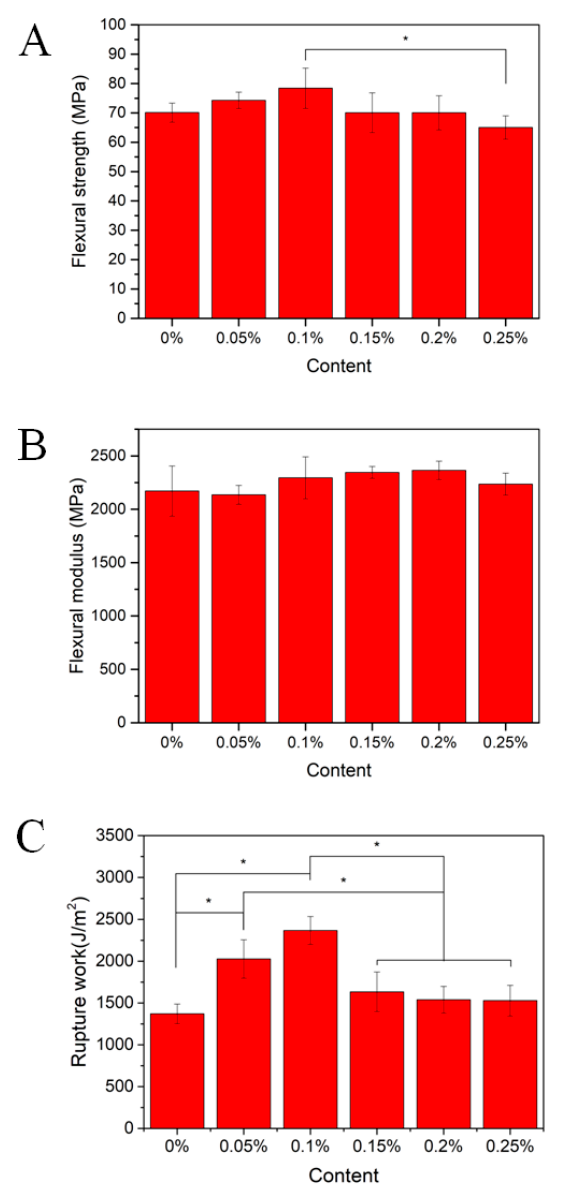
Figure 4. Flexural properties and impact resistance of PMMA resin containing CNCs-Ag with different mass concentrations: ( A ) Flexural strength; ( B ) flexural modulus; ( C ) rupture work.